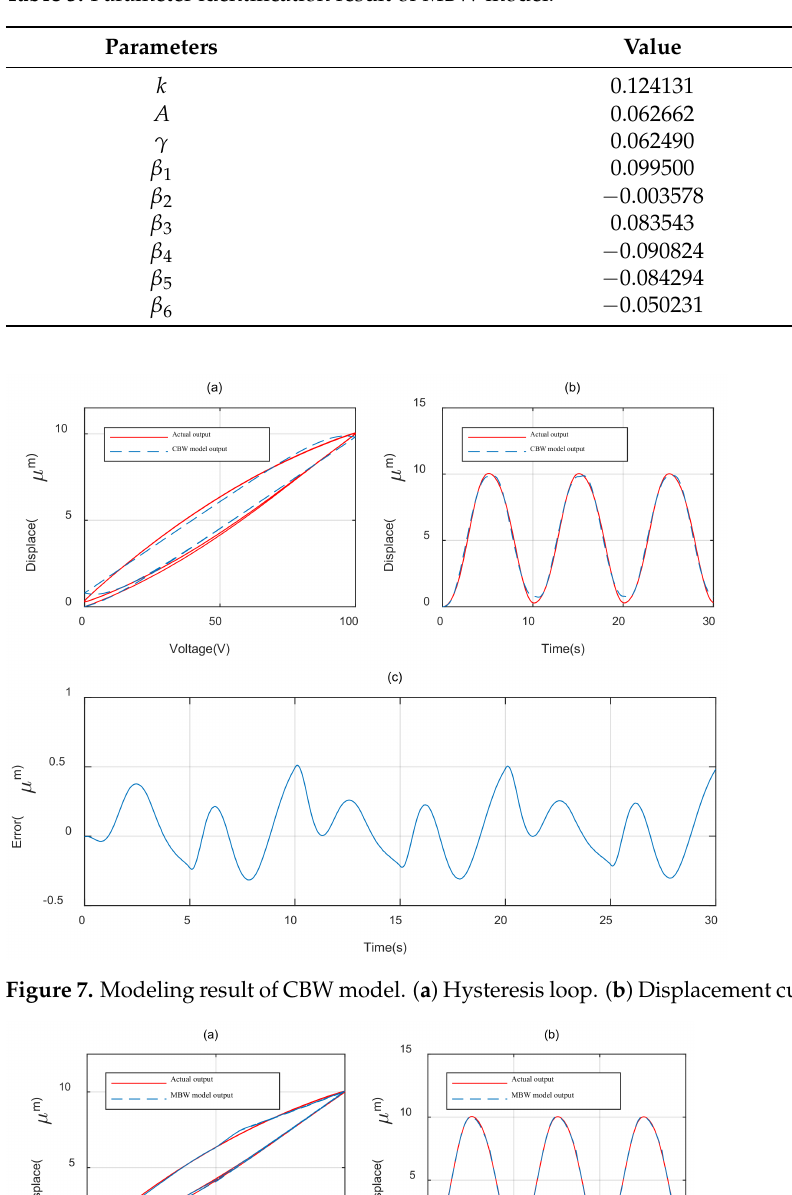
Table 3. Parameter identification result of MBW model.